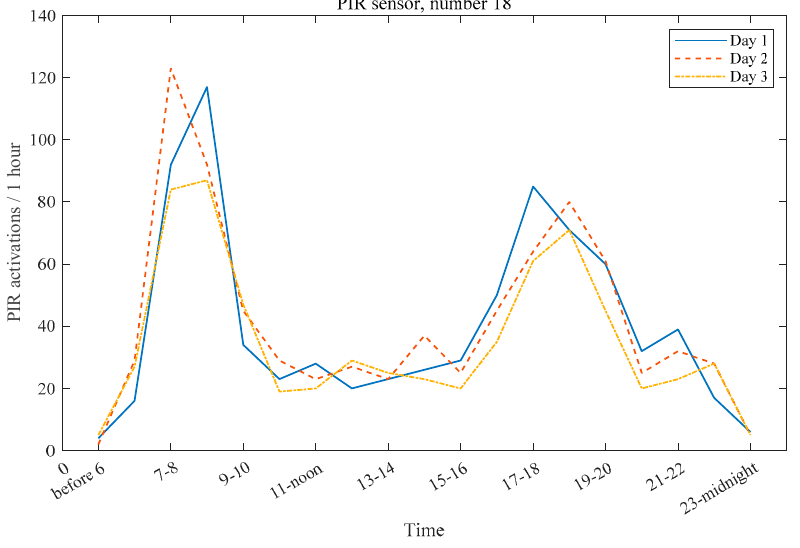
Figure 10. PIR activations in a 24-h period.